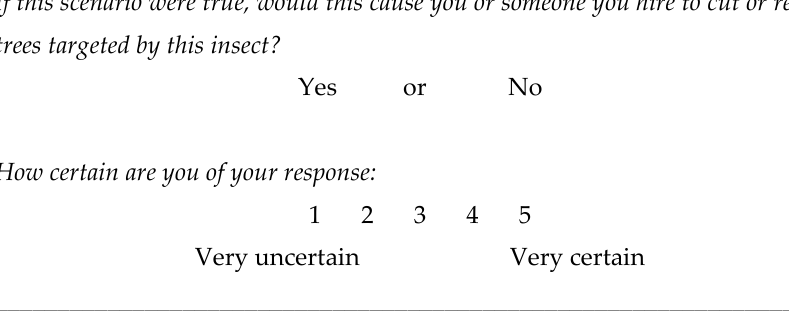
Figure A1. The scenarios presented to the FFOs in harvest intent survey. Respondents received four 138 different versions of the scenario within their survey and were asked whether they intended to harvest 139 in response to each scenario uniquely. 140 Protection